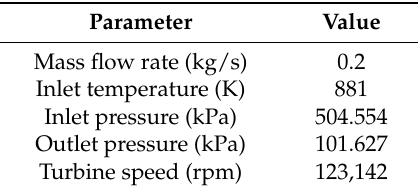
Table 1. Baseline turbocharger data.